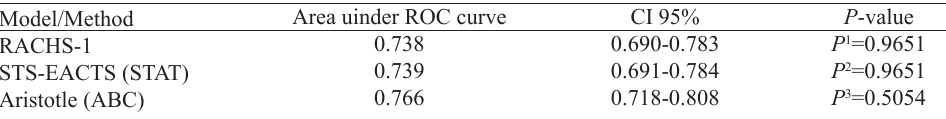
Table 5. Results regarding area under the ROC curve and comparative results between the methods concerning the mortality outcome.